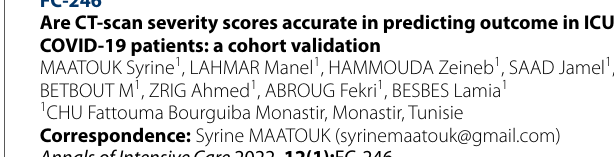
Table I: Patient outcomes according to CT extent of parenchymal lesions COVID-19 FC‑246 Are CT‑scan severity scores accurate in predicting outcome in ICU COVID‑19 patients: a cohort